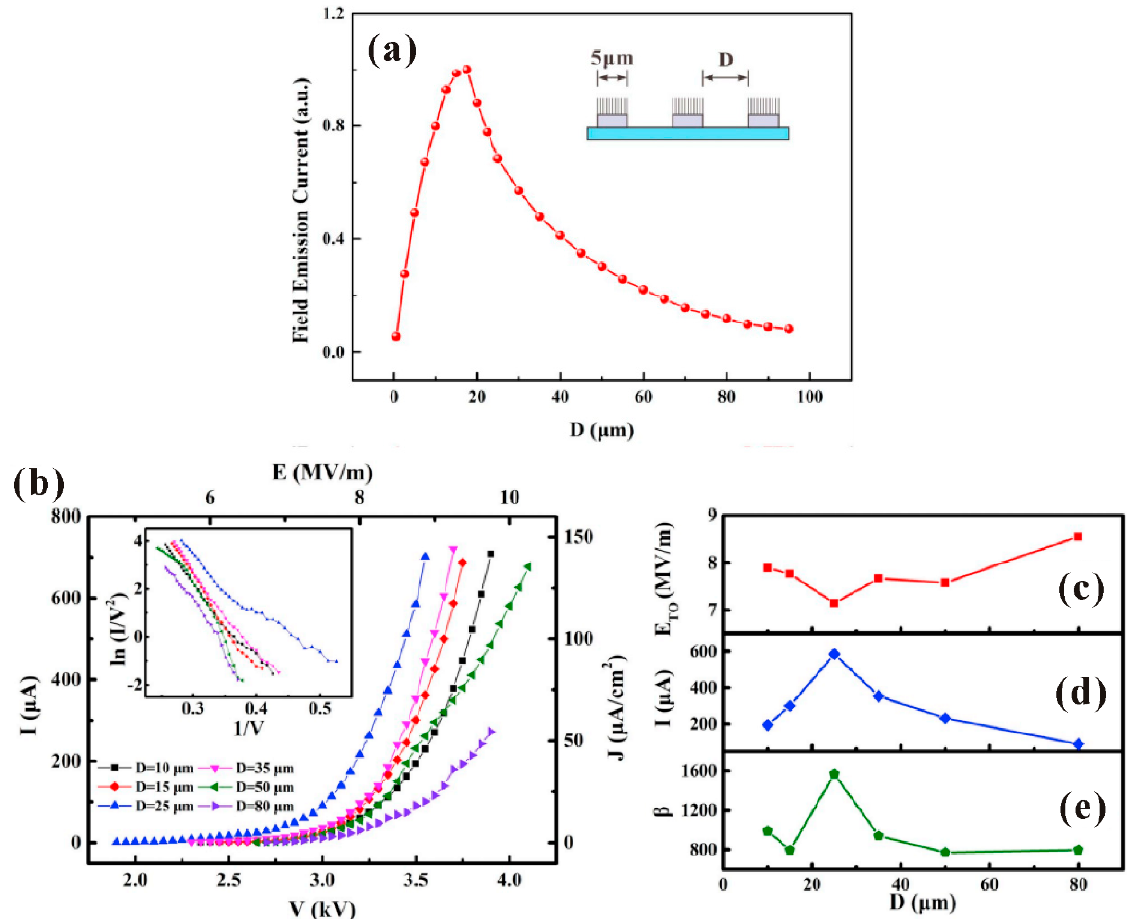
Figure 22. Field-emission properties of ZnO nanowires with different array spacing. ( a ) Simulated result. ( b ) Experimental result. The dependences of array spacing on the turn-on field ( c ), emission current ( d ) and the fitted β ( e ). Reproduced from [40], with the permission of Elsevier, 2019.